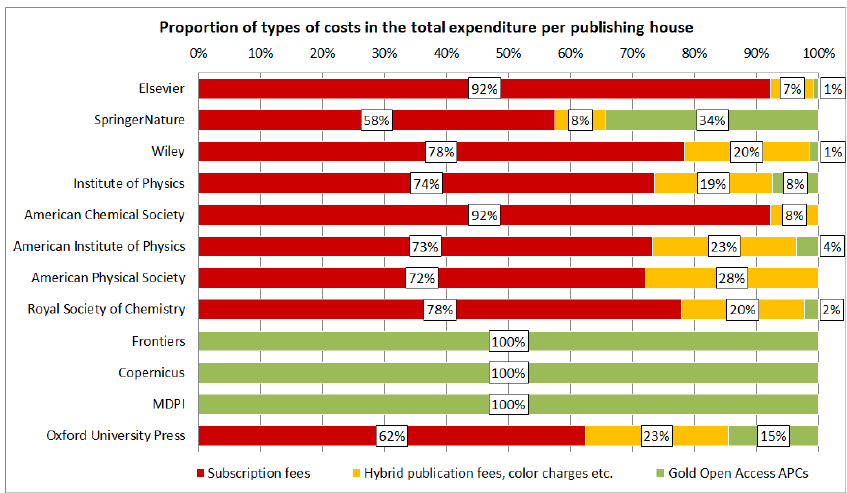
Figure 2. Proportion of types of costs in 2017. Source: Forschungszentrum